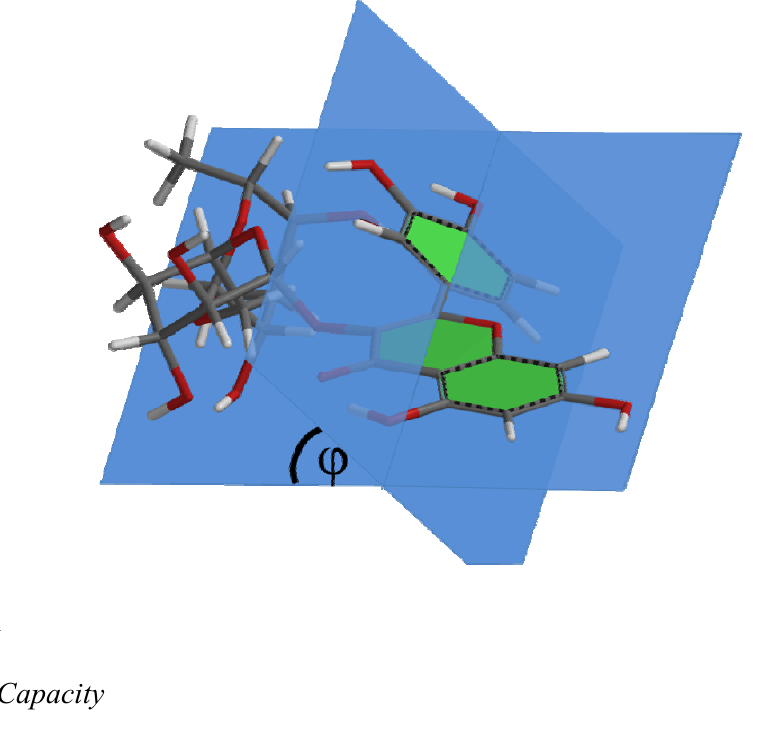
Figure 1. Three dimensional structure of rutin ( R1 ), illustrating the dihedral angle ( φ ) of 38° between the plane of the AC-ring and that of the